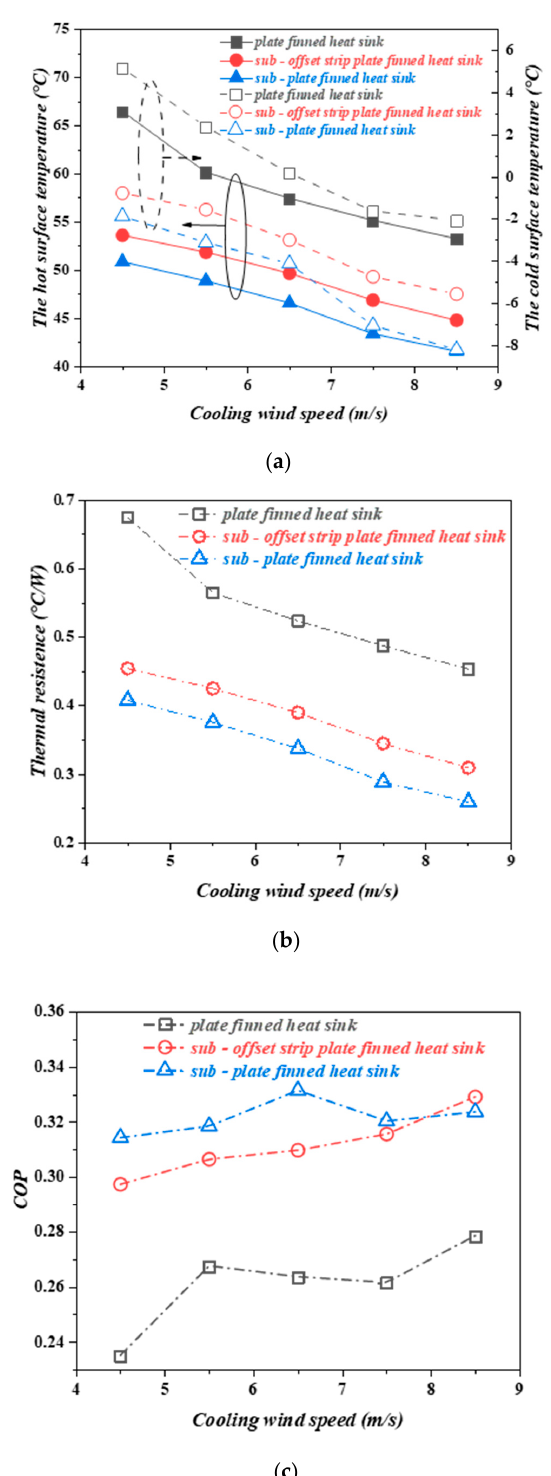
Figure 6. Comparison of heat sink performance under different cooling wind speed, ( a ) the hot and cold surface temperature, ( b ) thermal resistance of hot side, ( c ) COP. ( 𝐼 (cid:3404) 5 A ).